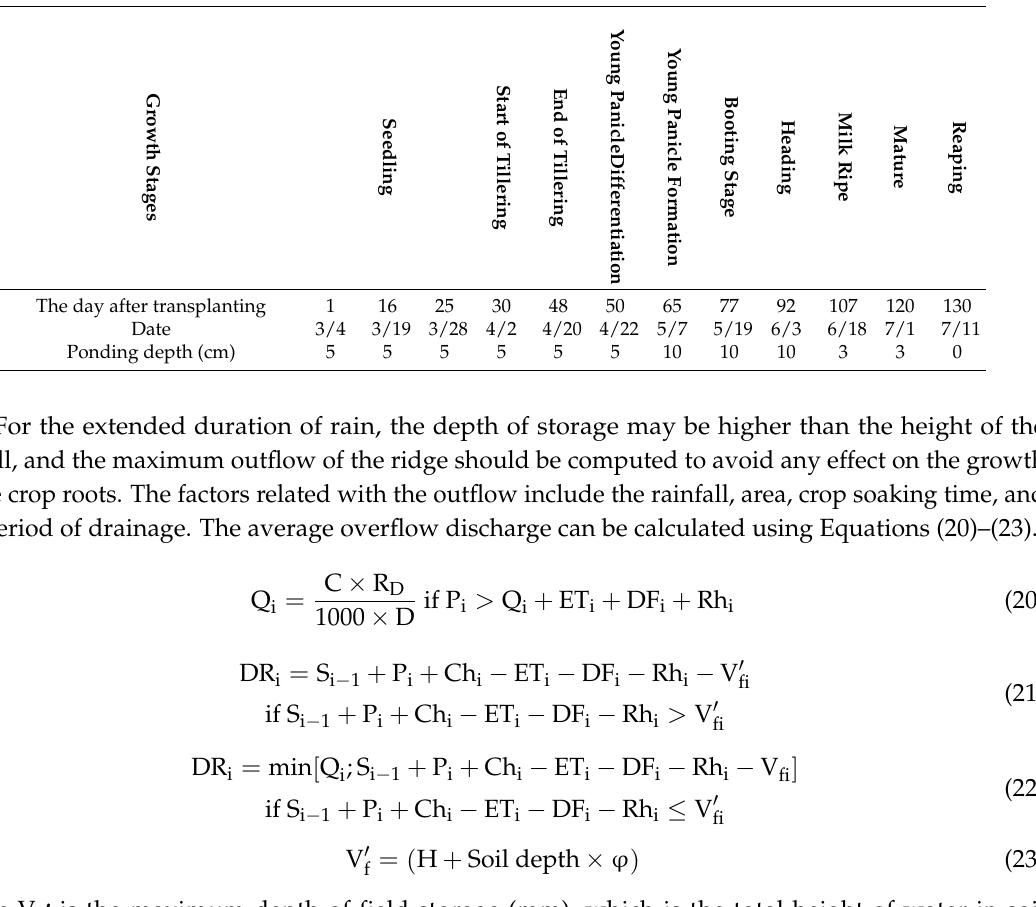
Table 3. Ponding depth during the first crop season of paddy rice in